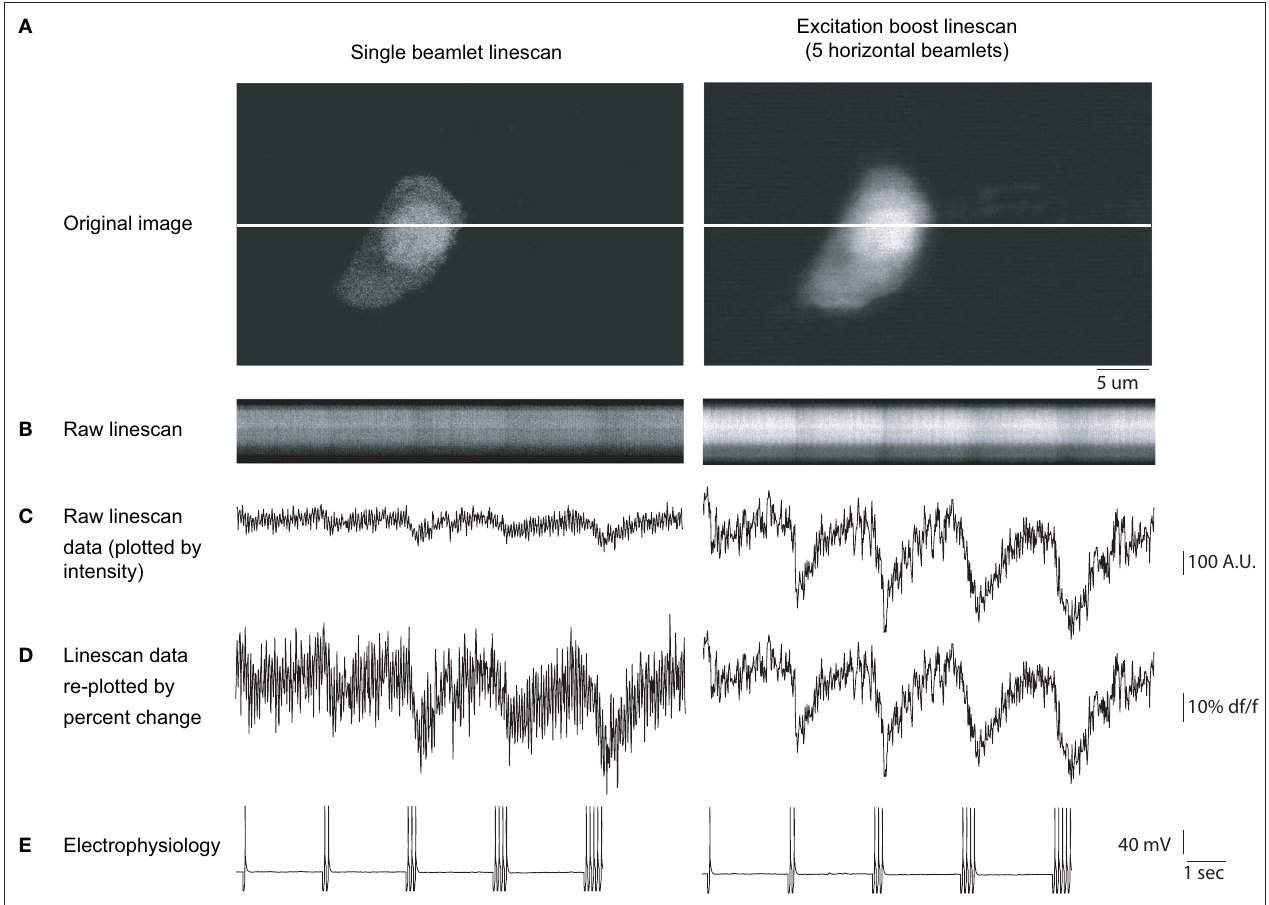
FIGURE 3 | Line scanning with a horizontal DOE. Line scan imaging using horizontal DOE scanning. (A) Full-frame raster scan images of a neuron fi lled with Fura 2 pentapotassium salt acquired using traditional single beam excitation (left) and fi ve beamlet excitation (right). Note that with multiple beamlets there is slight blurring of the image of the neuron, however the narrow spacing minimizes this blurring to the extent that the cell is clearly distinguishable. These images were used to select a level for line scanning (white horizontal line in each image). (B) Line scans acquired at 80 scans per second using single beam (left) and multibeam (right) excitation, time is represented in the horizontal axis, each vertical column represents one scan. A limited spatial extent of the line scan which includes the cell soma is shown for display purposes. The neuron was patch clamped and driven to fi re action potentials during the optical recording. (C) Intensity versus time profi les of linescans shown in (B) . Raw brightness